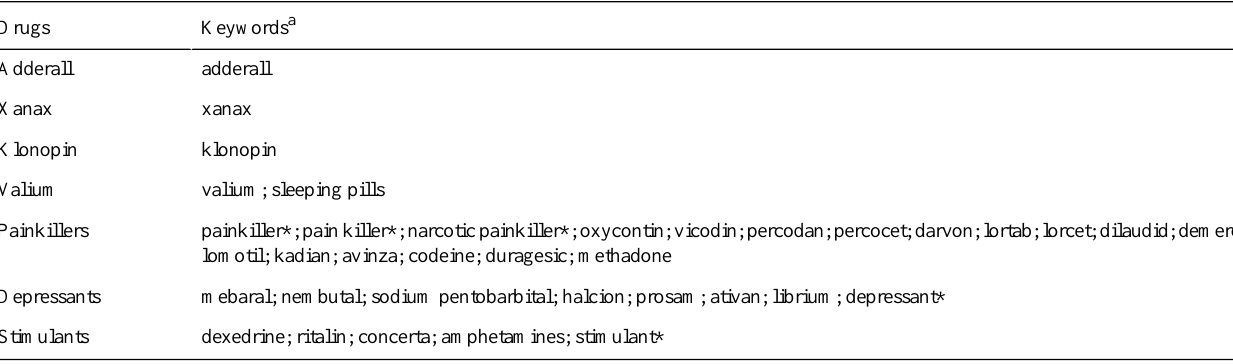
Table 1. Keywords for prescription drugs.